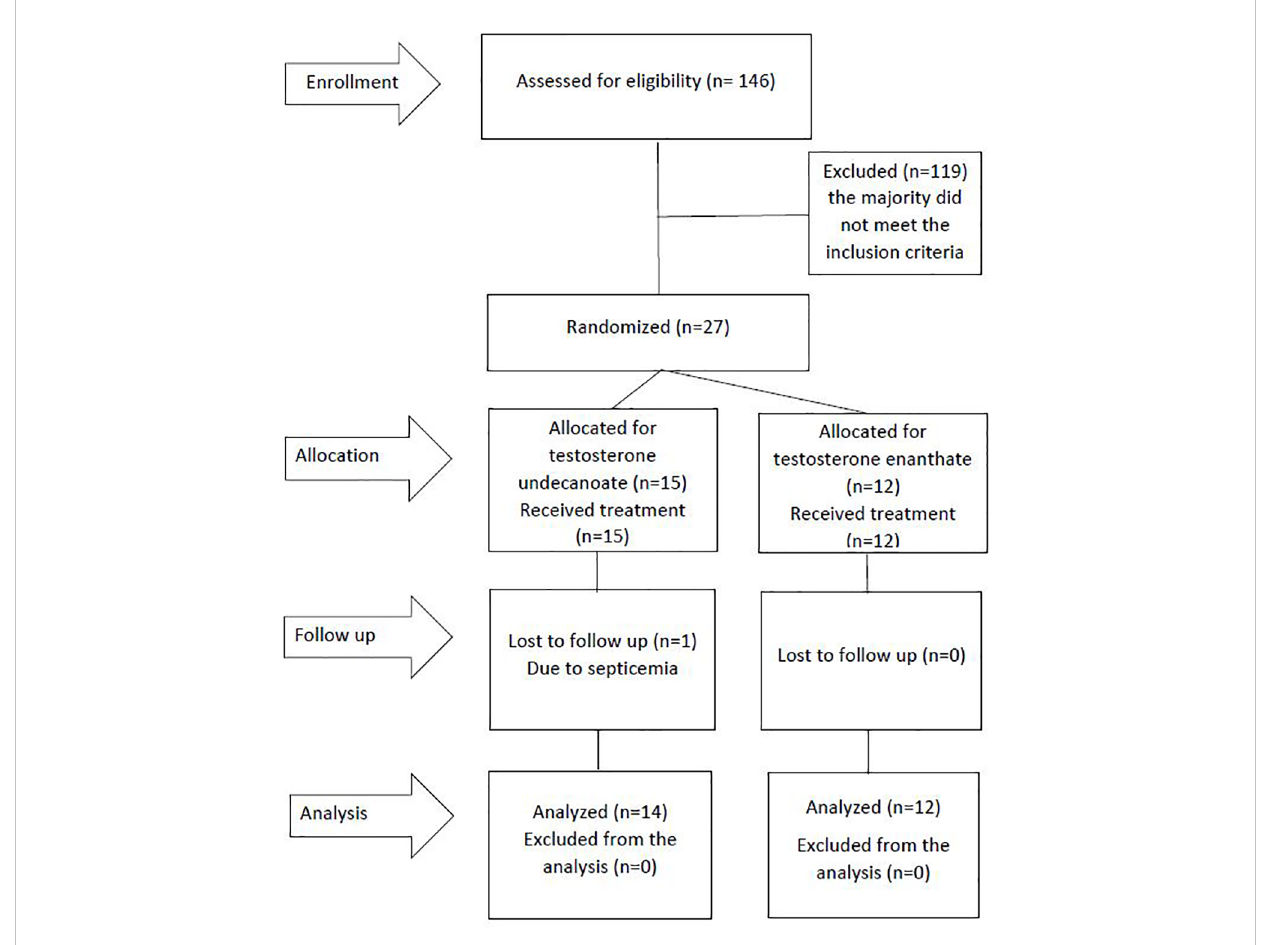
FIGURE 1 Flowchart of patient recruitment in the Pubertal Replacement in Boys Study.